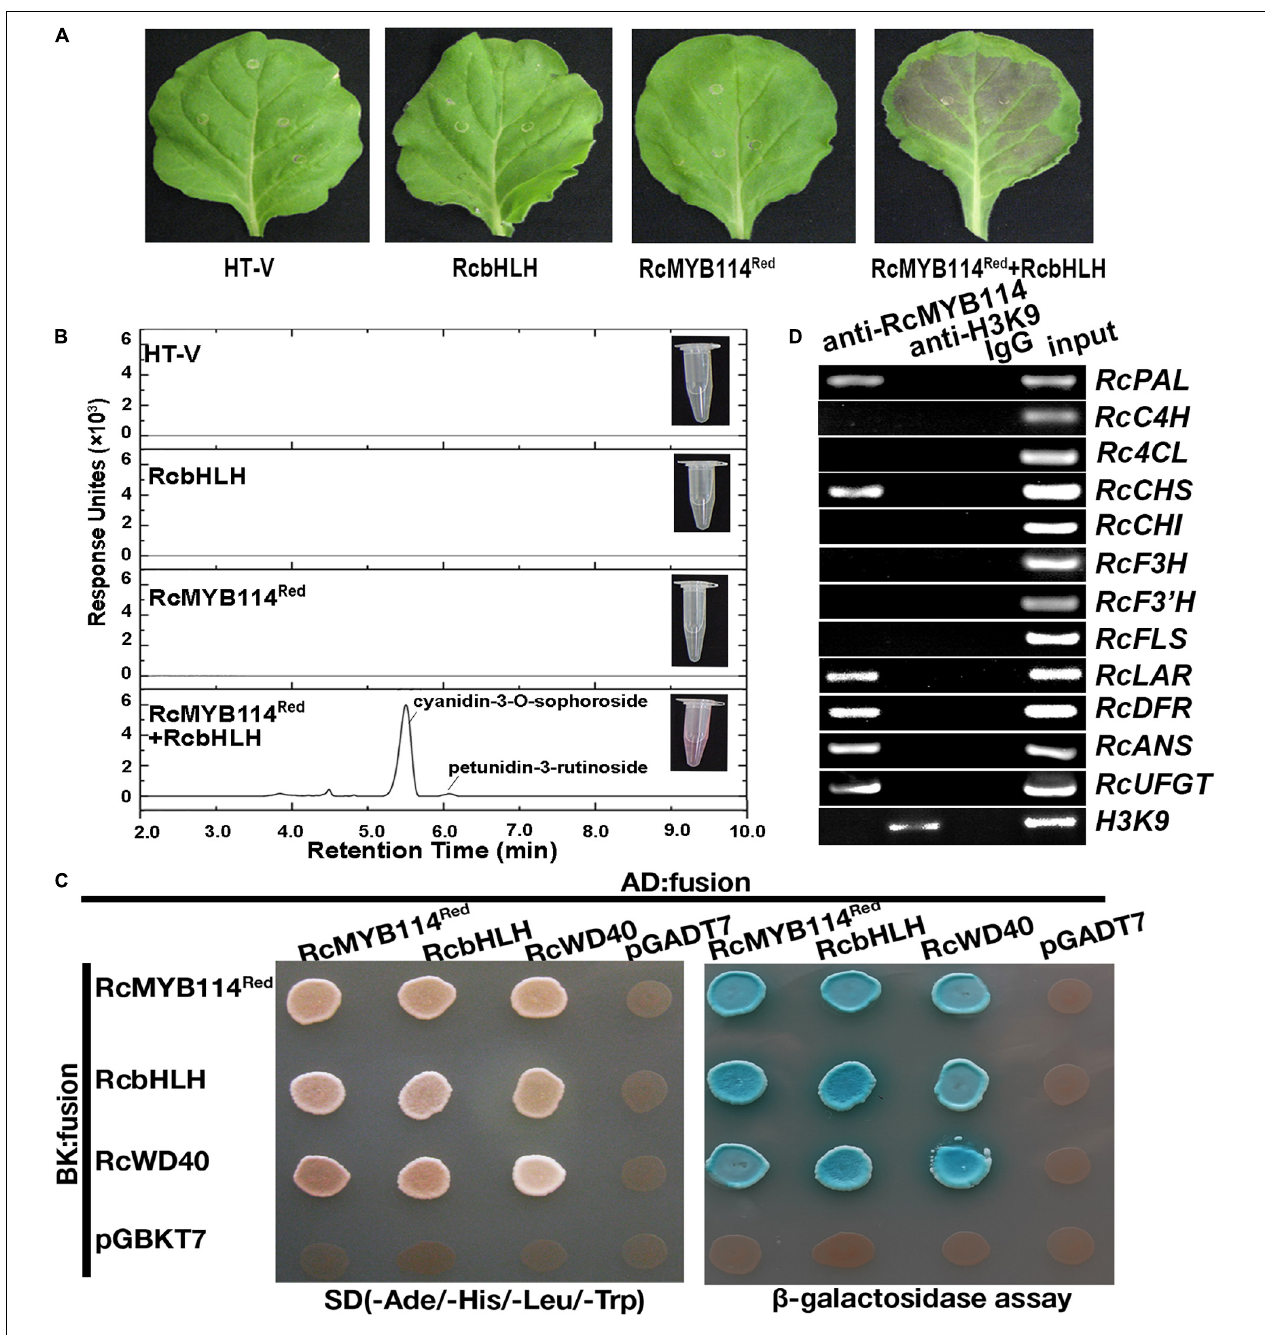
FIGURE 2 | Confirmation of the role of RcMYB114 in regulating anthocyanin biosynthesis. (A) Leaf phenotypes of N. benthamiana after being infiltrated with different constructs or the empty vector (HT-V). (B) Anthocyanins from the infiltrated N. benthamiana leaves were assayed by UPLC-MS/MS. (C) The yeast two-hybrid (Y2H) assay to probe the interaction of RcMYB114 with RcWD40 and RcbHLH within the MBW complex. The co-transformants were screened on media ( − Ade/ − His/ − Leu/ − Trp). β -galactosidase tests were performed on the same plate and positive clones were dyeing by using 3–5 µ L 4 mg/mL X- α -gal, and false-positive activation was excluded using the P53 plus SV40 vector. (D) RcMYB114 was selectively recruited to RcPAL , RcCHS , RcLAR , RcDFR , RcANS , and RcUFGT promoter regions as determined by the ChIP assay. Anti-H3K9 was used as positive control and Anti-IgG was negative control.